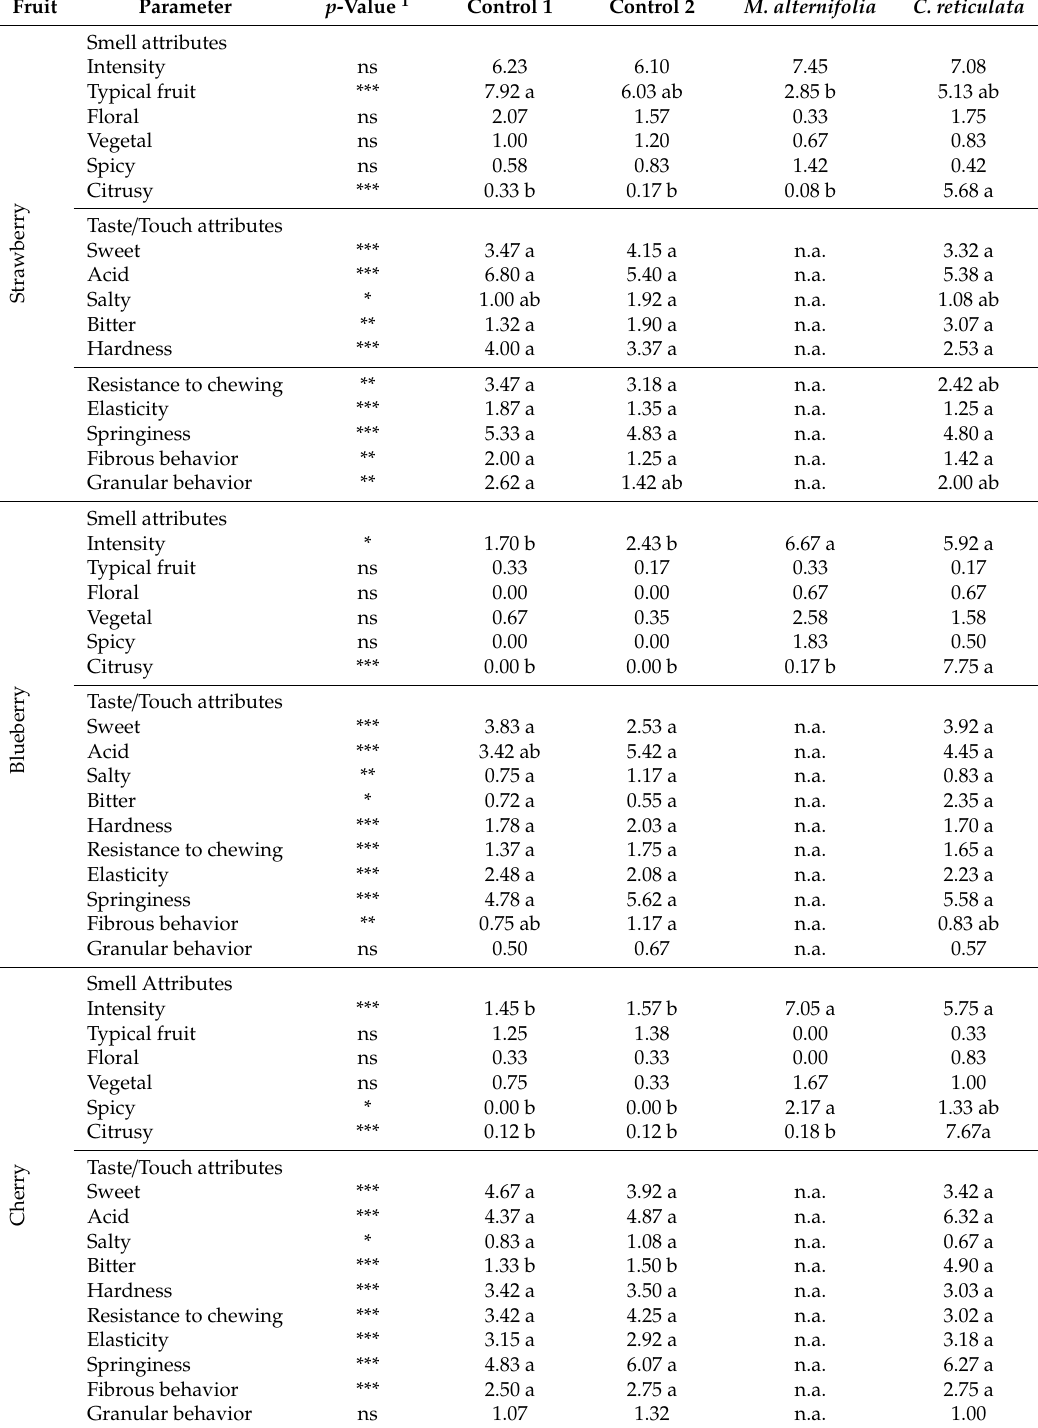
Table 5. Quantitative parameters of the sensory analysis ranked by panelists during the tasting of fruits treated with Citrus reticulata and Melaleuca alternifolia essential oils. Fruit